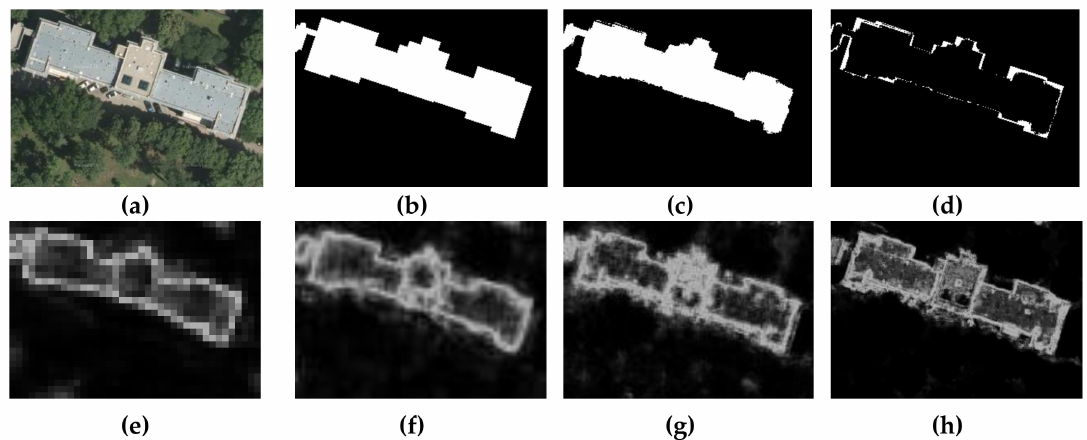
Figure 2. Entropy score maps of four-scale spatial attention mechanisms. ( a ) is the original image; ( b ) is the ground truth; ( c ) is the prediction result; ( d ) is the error map; ( e – h ) are the entropy score maps of the low-to-high scale spatial attention mechanisms.